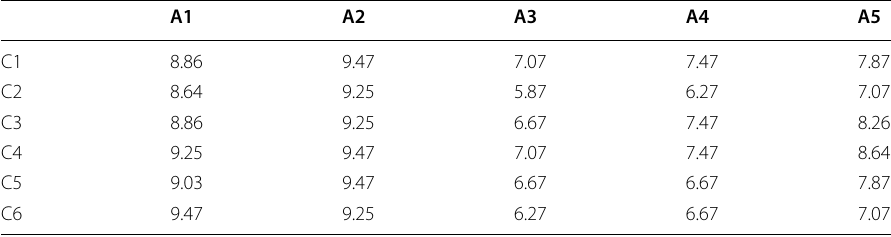
Table 14 Defuzzified decision matrix. Source : Author’s own table